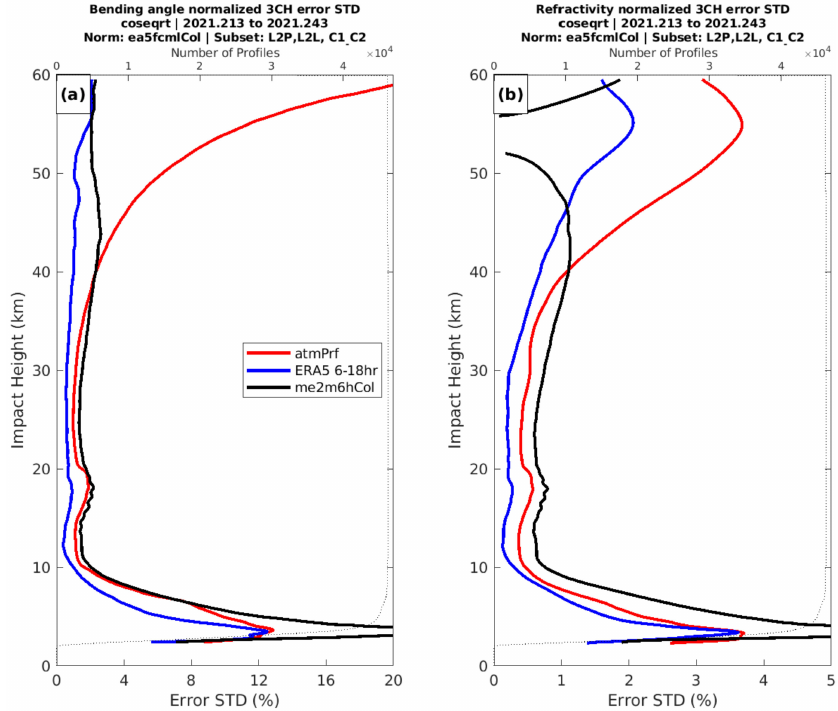
Figure 8. Vertical profiles of error STD (uncertainties) of bending angle ( a ) and refractivity ( b ) of C2 (GPS only), ERA5, and MERRA-2 for August